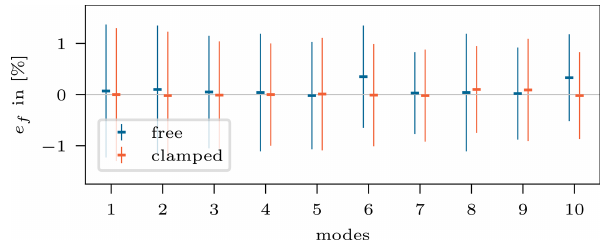
Figure 16. Mean values (a) and standard deviations (b) of the MAC matrix for the free–free modal configuration based on 1000 spline samples inferred for one target response.